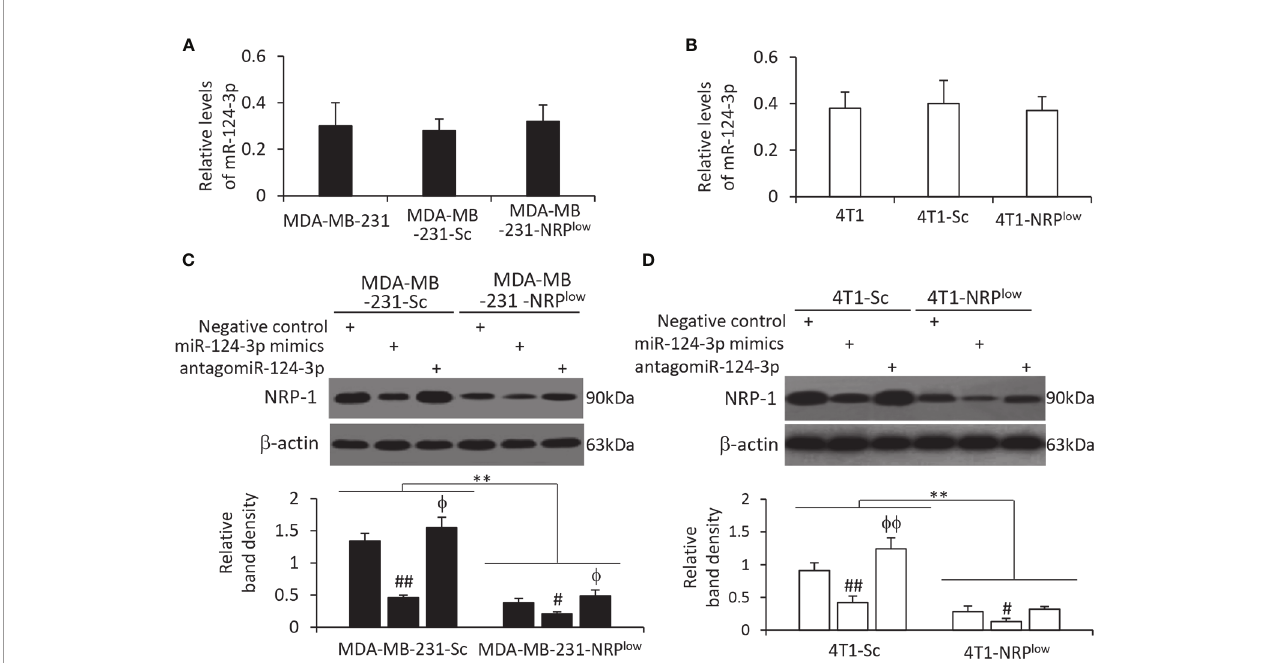
FIGURE 4 | The alteration of NRP-1 expression by transfection of oligonucleotides targeting miR-124-3p. (A, B) MDA-MB-231, MDA-MB-231-Sc, MDA-MB-231- NRP low , 4T1, 4T1-Sc and 4T1-NRP low cells were subjected to qRT-PCR to measure the expression level of miR-124-3p. (C, D) Cells as indicated were transfected with negative control, miR-124-3p or antagomiR-124-3p oligonucleotides for 48 h and then subjected to Western blotting analysis. Band density was normalized to b -actin. A one-way ANOVA with a Tukey post-hoc test was used for statistical analysis. “ **P < 0.001 ” indicates a signi fi cant difference; “ f P < 0.05 ” and “ ff P < 0.001 ” indicate a signi fi cant increase, while “ # P < 0.05 ” and “ ## P < 0.001 ” , a signi fi cant reduction, compared with negative control-transfected cells.